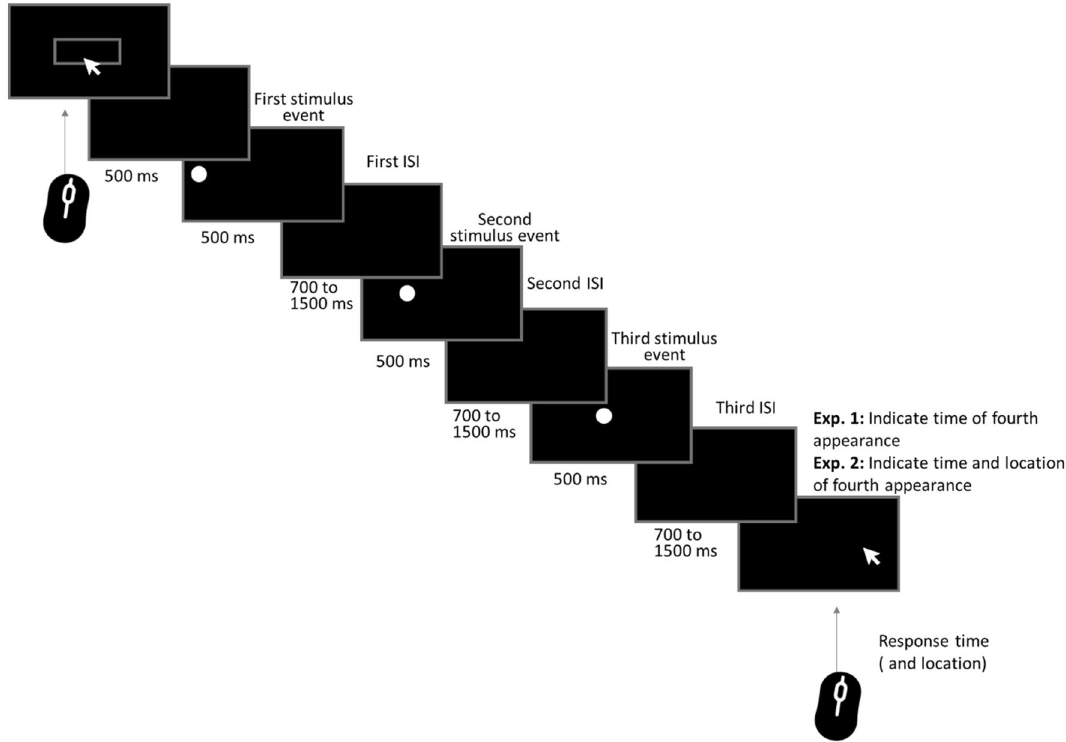
Figure 1. Structure of a single trial. Participants started each trial via a mouse/touchpad click. After a 500 ms pause, the visual stimulus was presented for 500 ms at the first location, it then disappeared for 700/900/1100/1300/1500 ms (interstimulus intervals = ISIs) before reappearing again for 500 ms at the second location (spatial intervals of 150/200/250/300/350 px). The disappearance and reappearance were repeated with the same temporal and spatial intervals and presentation times. After disappearing at the third location, participants were required to predict the fourth time (Exp. 1) and location (Exp. 2) of reappearance with the mouse or